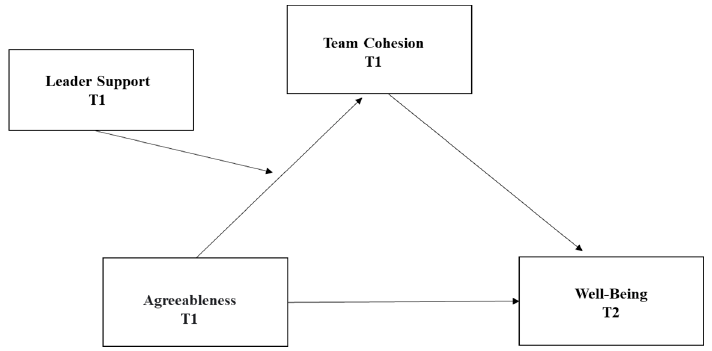
Figure 1. Study model.